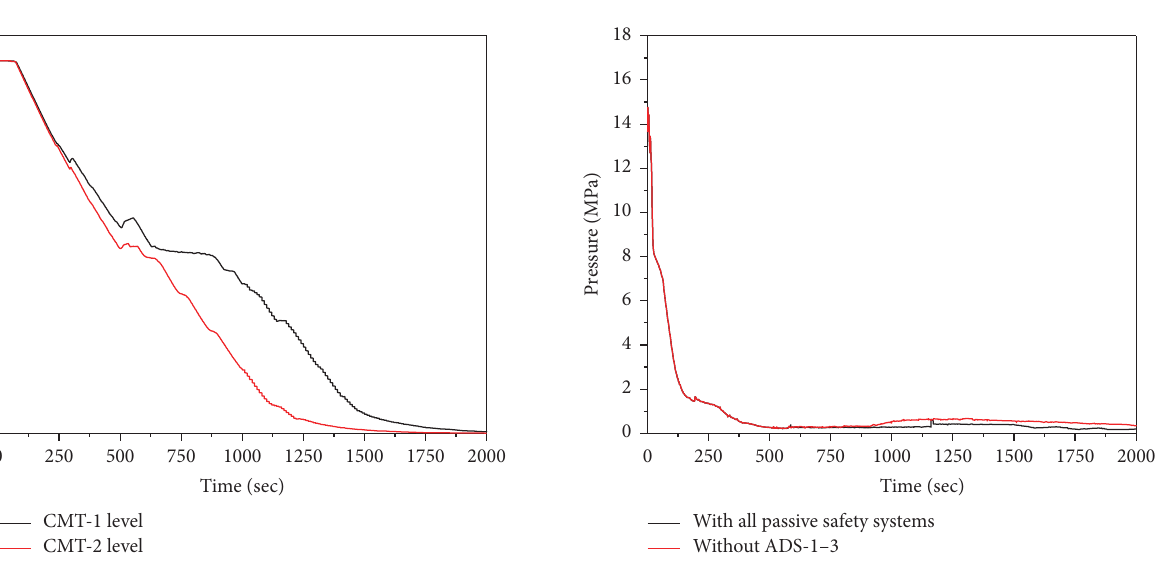
Figure 10: Comparison of CMTs level in case-2.